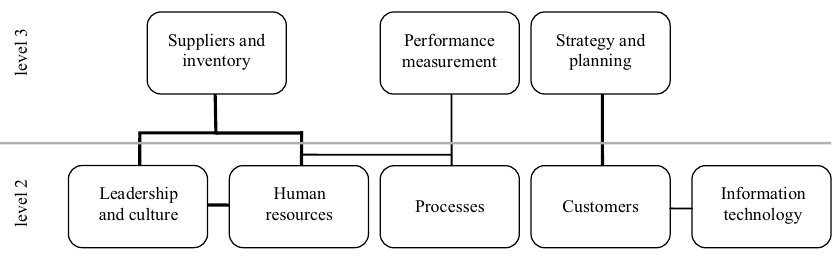
Fig. 1. Supply chain management maturity improvement